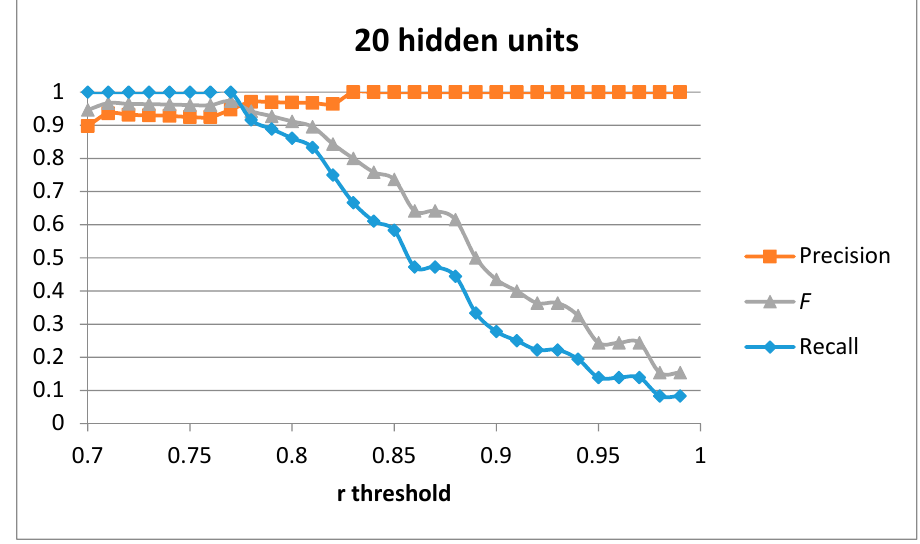
Figure 7. Precision, recall, and F score for 1 auto-encoder and 20 hidden units.